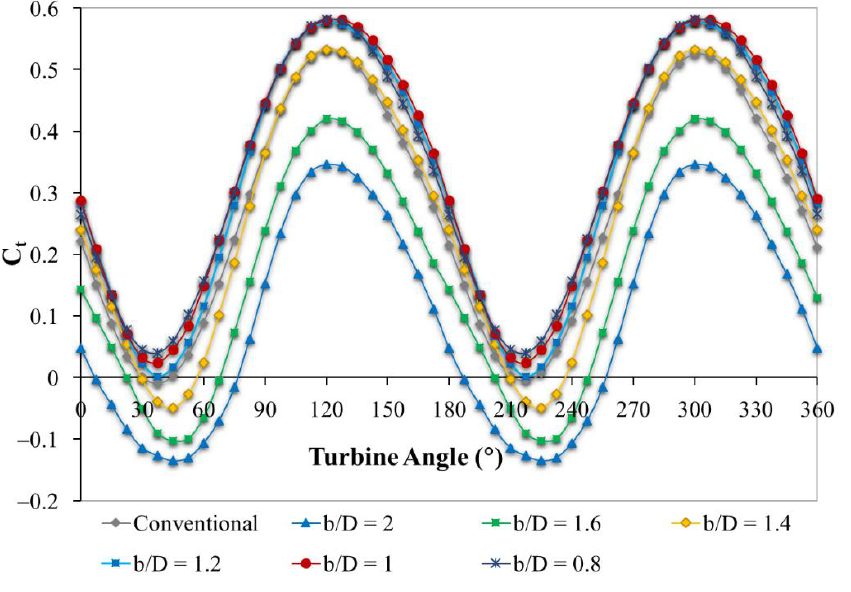
Figure 11. The effect of triangular plate base width.